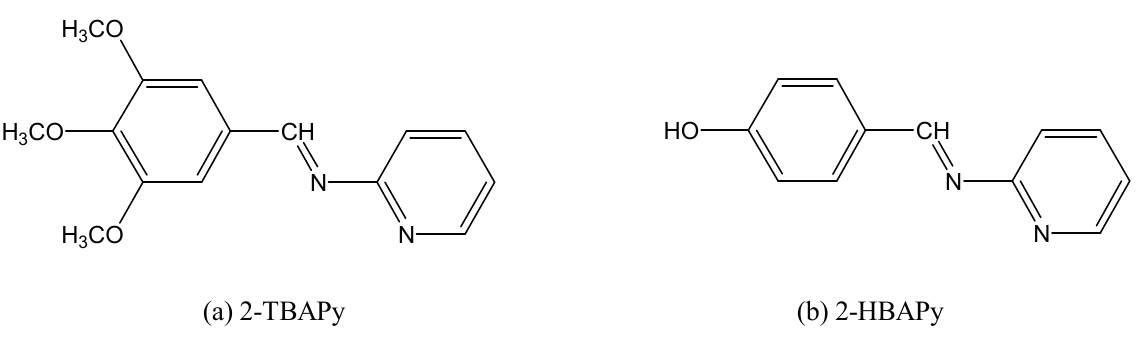
18. ( a ) 2 N -[3,4,5-trimethoxybenzylidene]aminopyridine and ( b ) 2 N -[4- hydroxybenzylidene]aminopyridine.